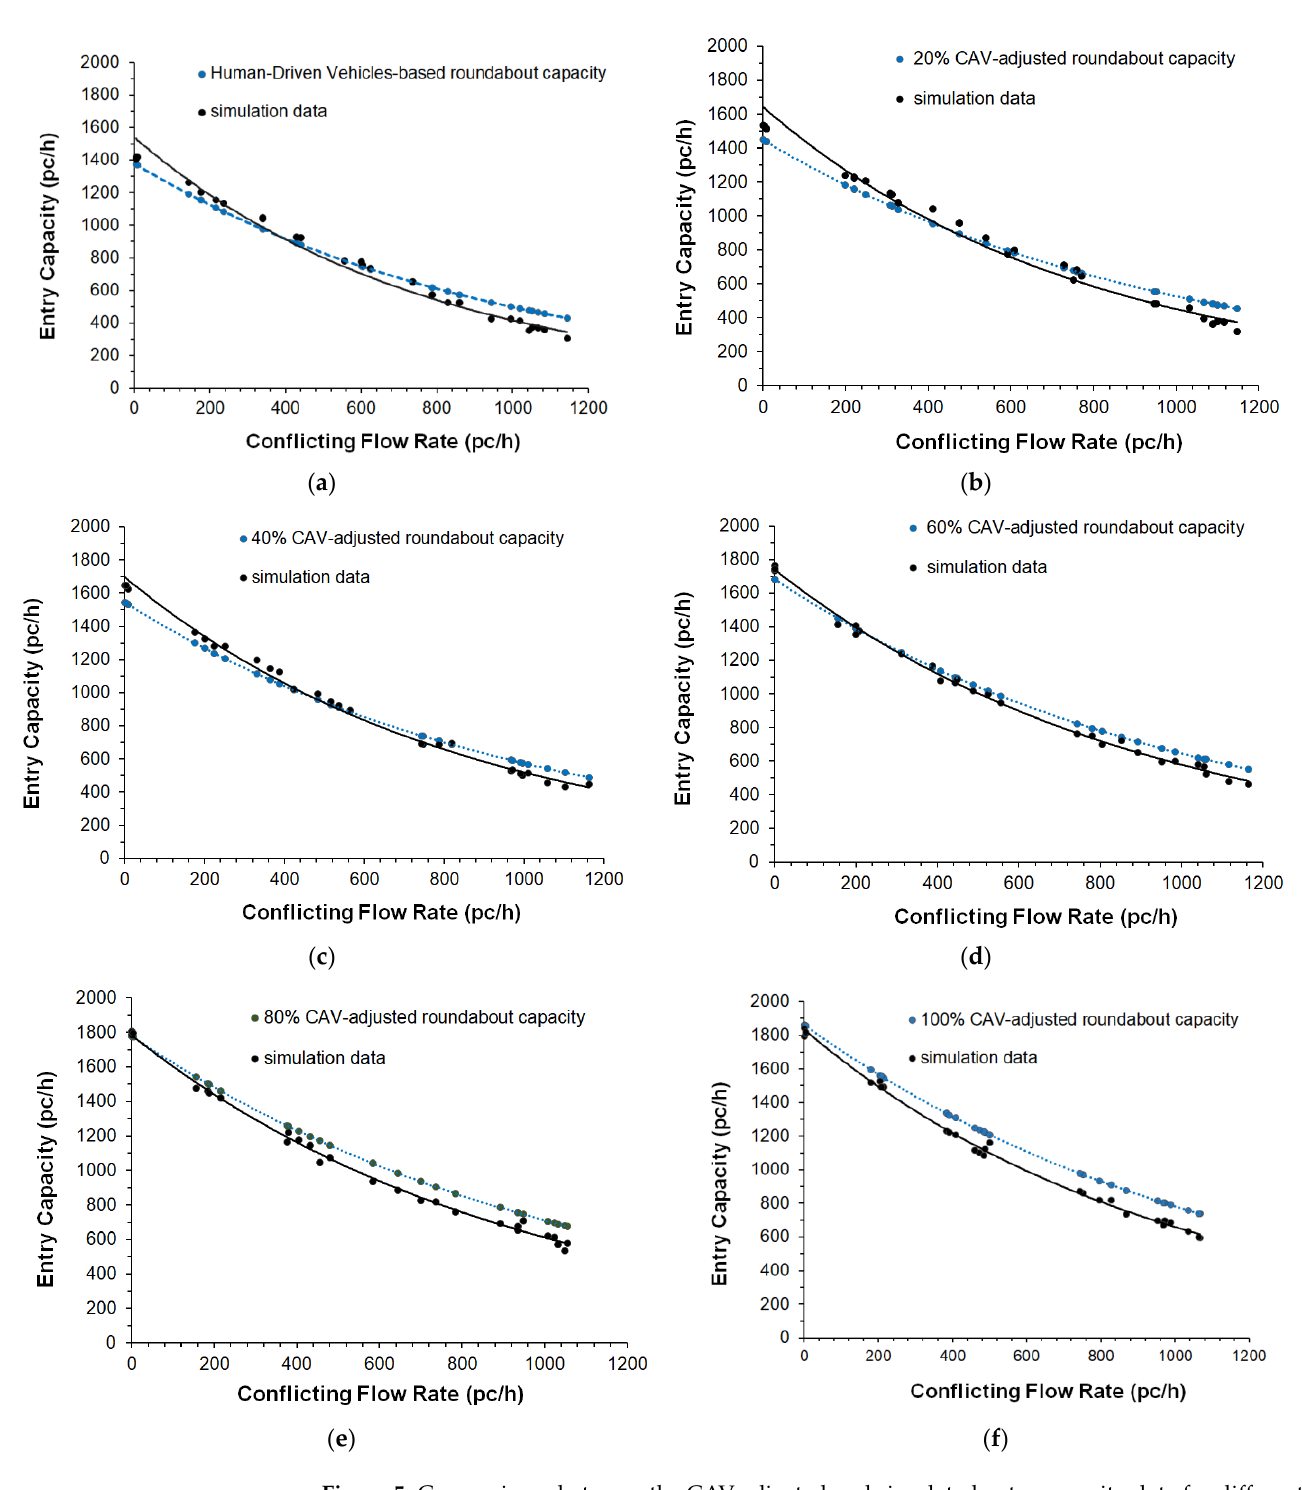
2 are the means of the samples of equal size, while s.e. stands for the standard error for the mean; 2 95% confidence interval for difference in means; 3 t -statistic from the t -test on N = 70 degrees of freedom at the significance level α = 0.05; 4 p (α) -value is the probability under null hypothesis of equal means at the significance level α = 0.05; 5 F -statistic from the two-tailed F -test: the hypothesis that the two variances were equal is rejected if F- statistic > F- critical value; 6 F -critical value of the F distribution is 𝐹 𝛼,𝑁 with N 1 − 1 and N 2 − 1 degrees of freedom and significance level of α = 0.05; 1 −1,𝑁 2 −1 7 F-prob means the probability under null hypothesis of equal variances.